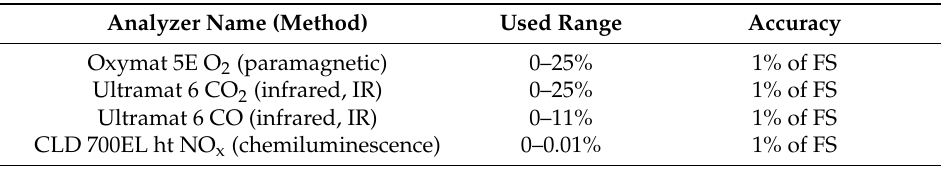
Table 1. Parameters of gas